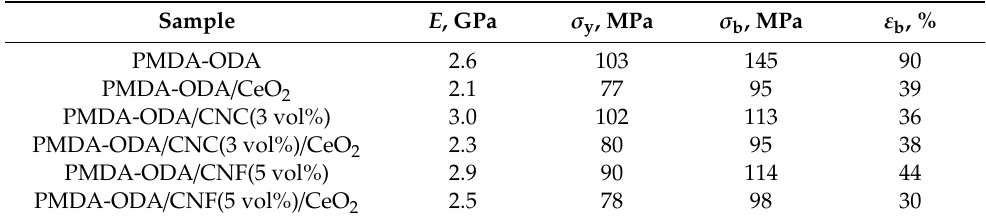
Table 4. Mechanical properties of the PMDA-ODA-based compositions.